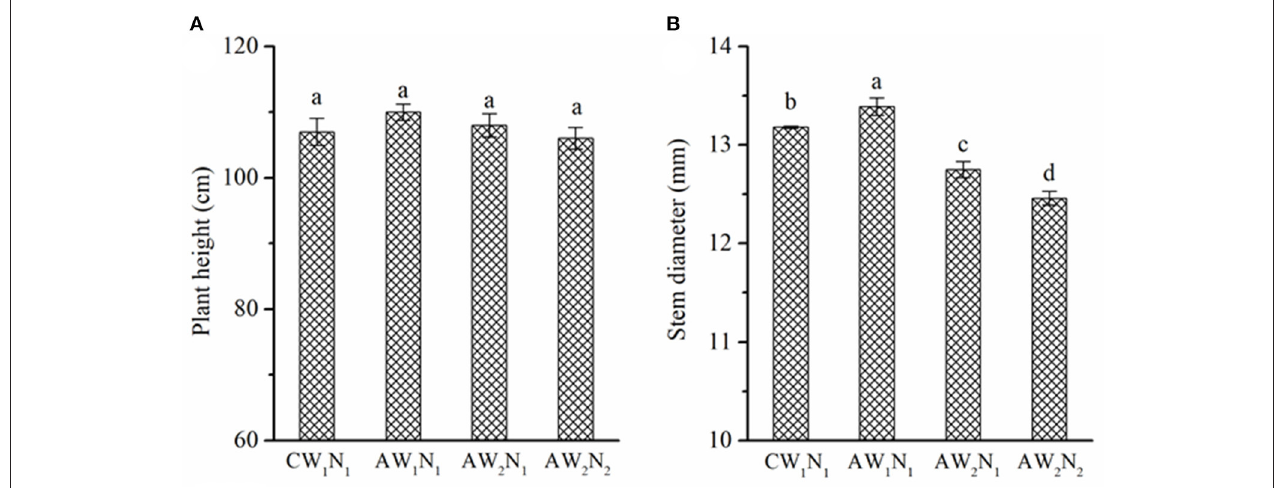
FIGURE 2 | The effects of irrigation and nitrogen (N) supply on the plant height ( A , cm) and stem diameter ( B , mm) of tomato plants under alternate partial root-zone drip irrigation. Values are the means ± SE. Different lowercase letters in the columns denote significant differences among the treatments ( P ≤ 0.05).